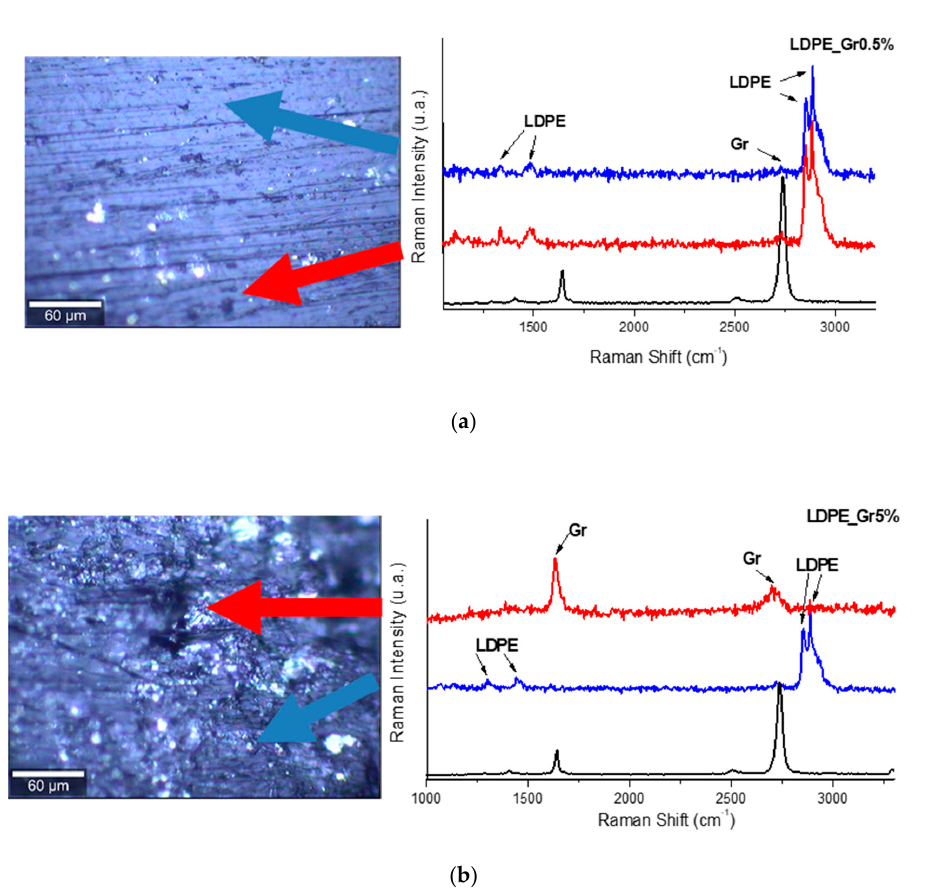
Figure 5. Raman spectra in two different points on the surface for two concentrations: ( a ) 0.5% and ( b ) 5%. The pristine-SL Graphene (black line) are presented as reference for band positions.